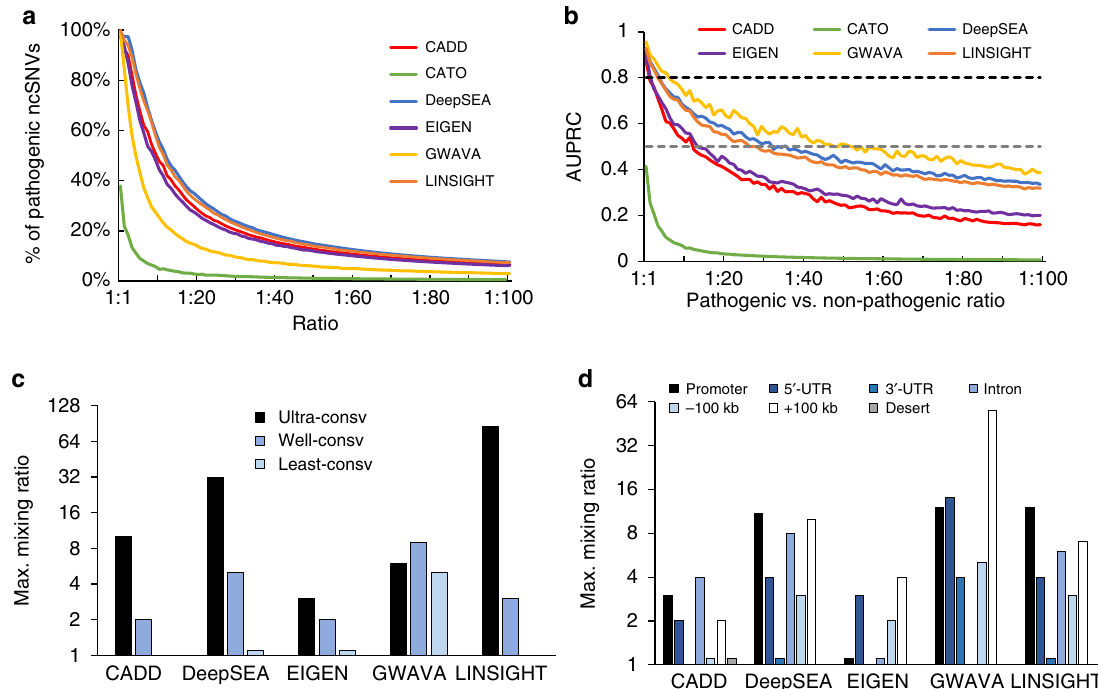
Fig. 3 Performance of tested methods on prioritizing GWAS hits. a Fraction of pathogenic ncSNVs in the top 10 percentile of impact scores declines exponentially as the mixing ratio increases. b AUPRC value decreases as the mixing ratio increases. The gray dotted line presents AUPRC = 0.5 corresponding to random predictions. The black dotted line presents AUPRC = 0.8 corresponding to a desired performance in practice. c Maximum mixing ratio for each tool to achieve AUPRC > 0.8 when pathogenic ncSNVs disrupt ultra-, well-, or least-conserved positions. d Maximum mixing ratio for each tool to achieve AUPRC > 0.8 when pathogenic ncSNVs are inside different types of genomic regions. Since the highest AUPRC of CATO in any category was lower than 0.8, we did not include it in panels c and d. In this task, we used GWAVA unmatched